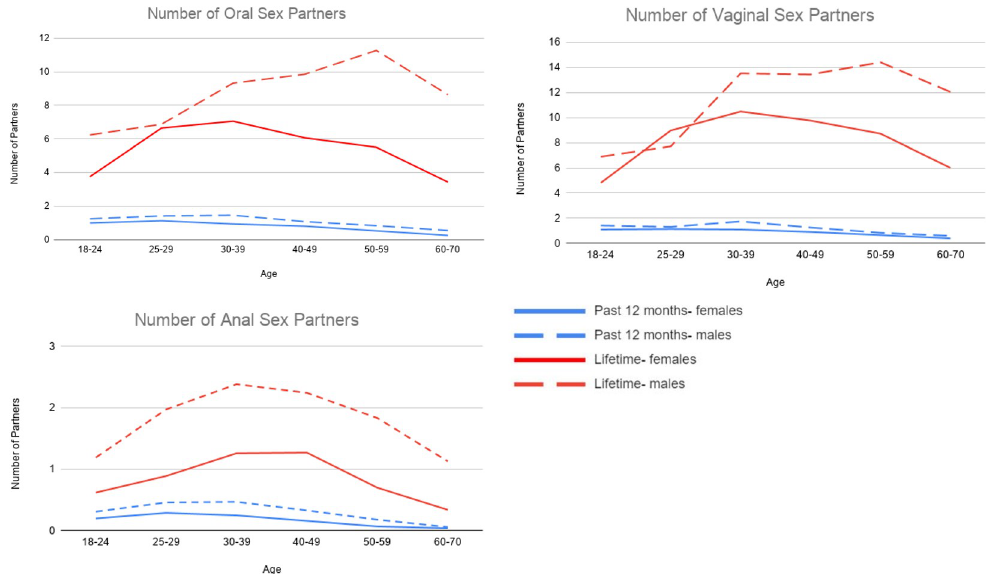
Fig 3. Age trends in mean number of oral, vaginal, and anal sex partners for lifetime and past 12 months. https://doi.org/10.1371/journal.pone.0255371.g003 those in a serious relationship (67.7%) reported a higher frequency of oral, vaginal, and anal sex during the past 12 months (mean d = 0.83) and the past 30 days (mean d = 0.76). This pat- tern was similar when comparing participants who were not dating to participants who were casually dating (4.6%) during the past 12 months (mean d = 0.81) and the past 30 days (mean d = 0.69), except for anal sex during the past 30 days. There were no significant differences between respondents who were casually dating and respondents in a serious relationship in the frequency of oral, vaginal, and anal sex in the past 12 months (mean d = 0.00) and past 30 days (mean d = 0.05). Table 5. Age of initiation of oral, vaginal, and anal sex (N = 1,987). Total ( n = 1,987) Years Men ( n = 953) Years Women ( n = 1,015) Years Men vs. Women Cohen’s d Oral sex Mean 19.5 19.8 19.3 0.07 Median 18.0 18.0 23.0 SD 5.9 6.4 5.4 Range 10 to 65 10 to 65 10 to 60 Vaginal sex Mean 18.5 18.6 18.4 0.05 Median 18.0 18.0 23.0 SD 4.7 4.9 4.6 Range 10 to 64 10 to 64 10 to 55 Anal sex Mean 24.3 24.3 24.3 0.00 Median 22.0 22.0 23.0 SD 8.1 8.7 7.5 Range 10 to 60 10 to 60 13 to 55 p Note. Cohen’s d = X-Y/ ((X 2 +Y 2 )/2). Youngest age capped at 10 years old.